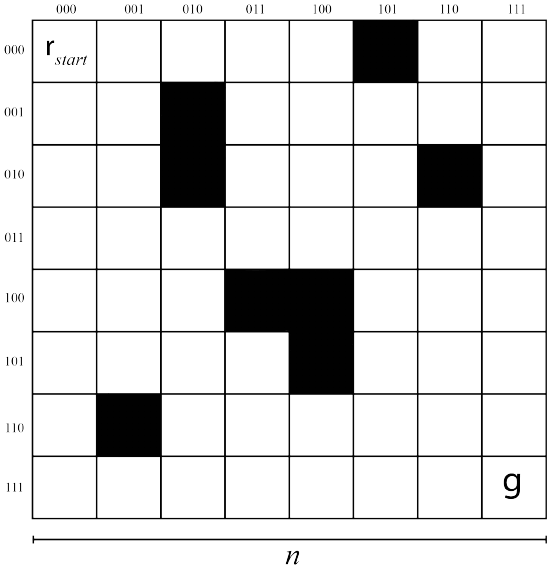
Figure 1. Example of the environment the robot lives in. The cell r start denotes the starting cell, while the cell labeled as g refers to the goal